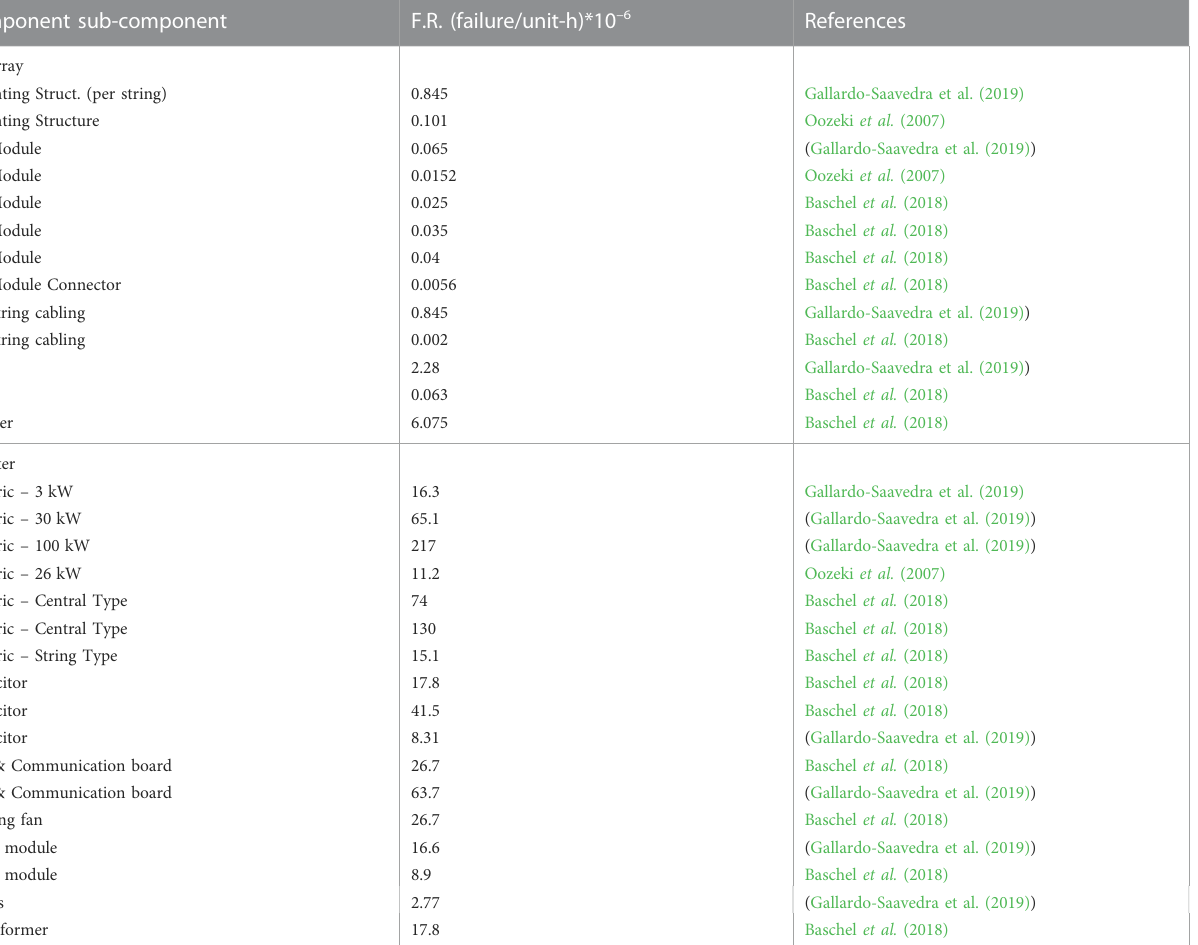
TABLE 5 Failure rate per unit hour of PV-Battery systems (Abdon et al. , 2020). Component